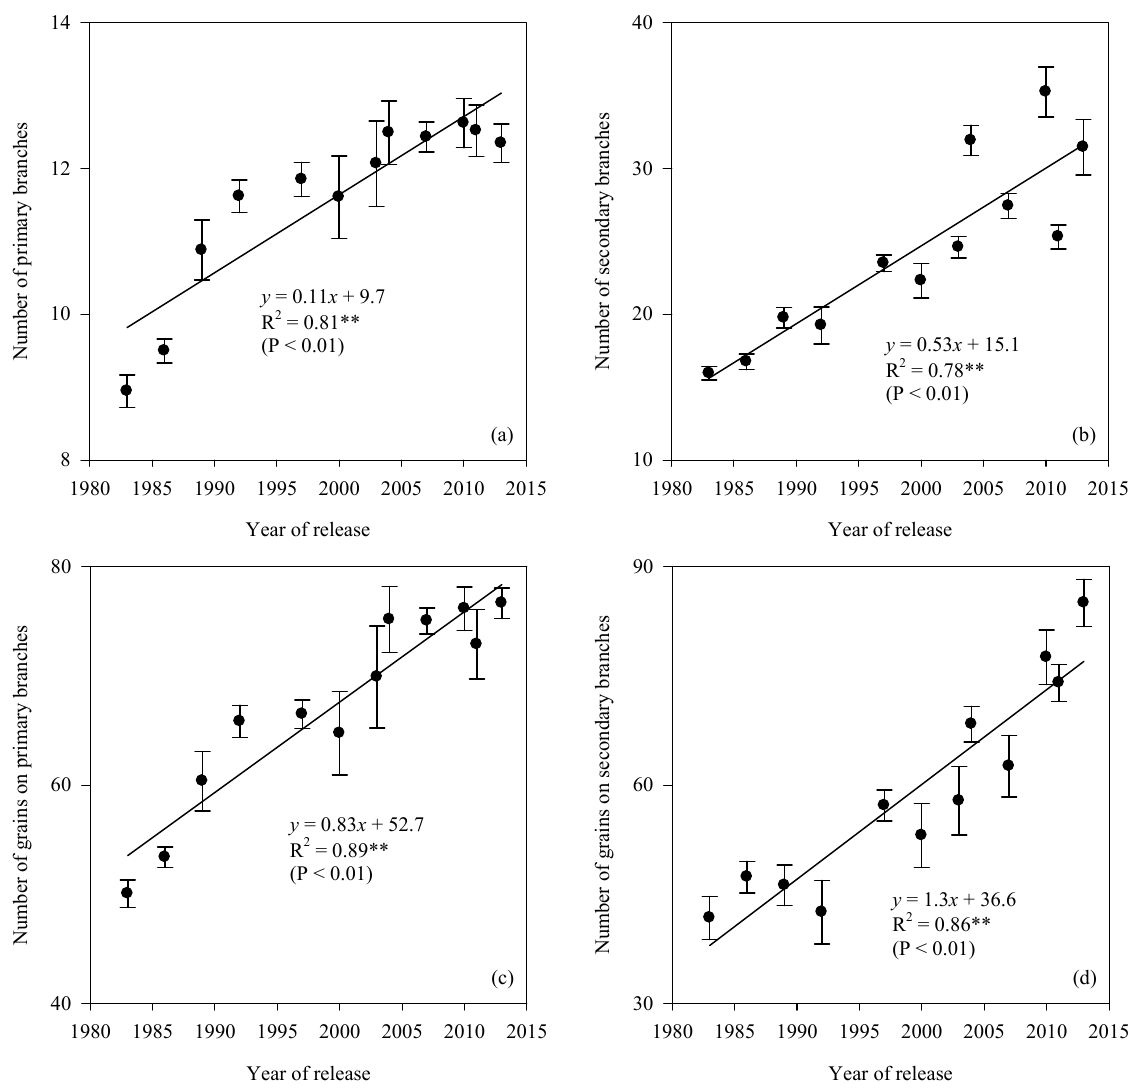
Figure 3. Relationships between year of release and number of primary and secondary branches ( a , b ) and number of grains on primary and secondary branches ( c , d ) of rice cultivars. Data were fitted by linear regression ( y = a x + b). In the linear regression, x was reassigned as years after 1983; for example, x was valued as 1 in 1983 and so on. **, significant at the 0.01 probability level according to the LSD test. Vertical bars represent ± standard error of the mean ( n = 6).